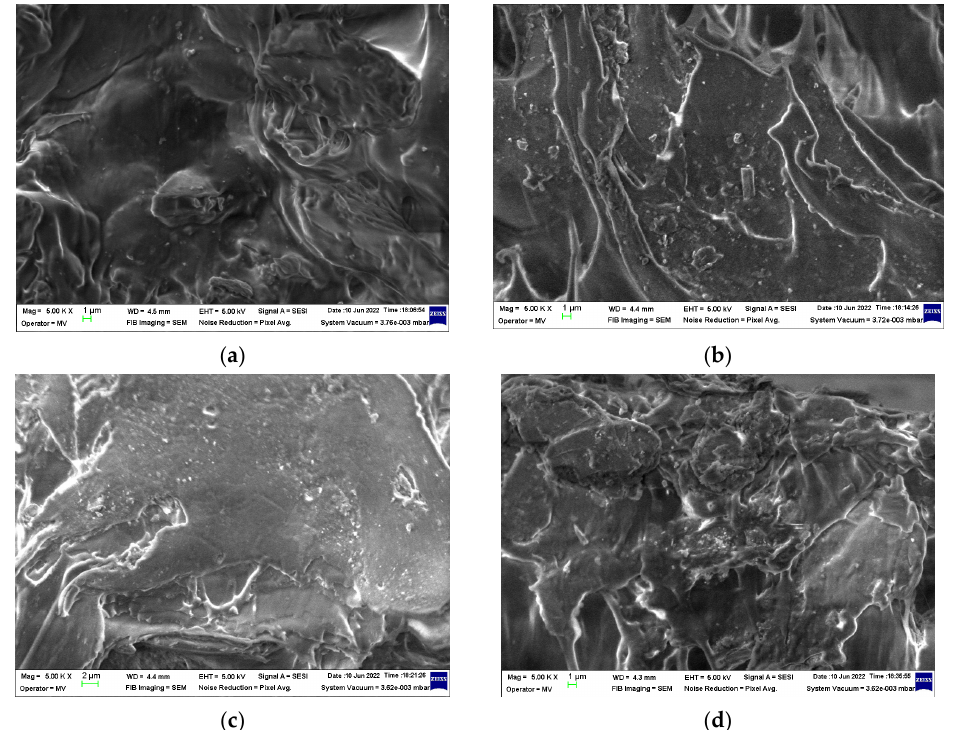
Figure 11. The SEM images on PLA/SIS 30 samples irradiated at 25 kGy. Compositions: ( a ) control; ( b ) SiO 2 3%, ( c ) SiO 2 5%, ( d ) SiO 2 10%. Magnification: 5 × 10 3 .